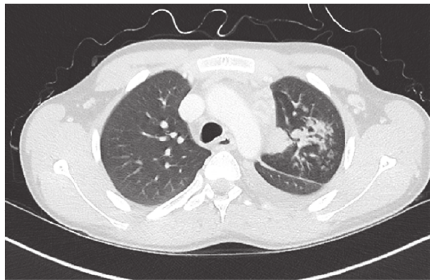
Figure 3: Compression of main bronchi by infracarinal lymph node/abscesses.